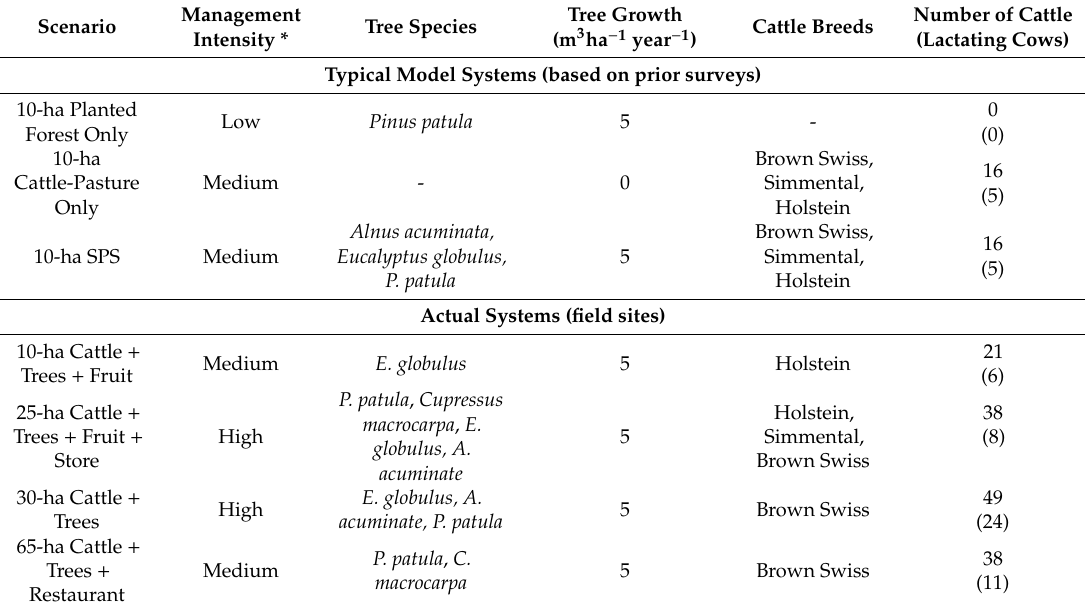
Table 1. Description of evaluated scenarios in Amazonas, Peru.